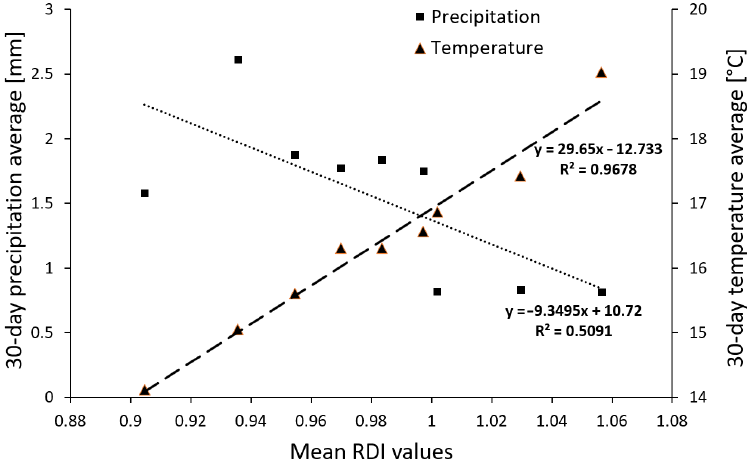
Figure 13. Correlation between mean RDI values of high temporally resolution maps and 30-day precipitation and temperature average calculated using meteorological data [41] for the area of the Donnersberg.